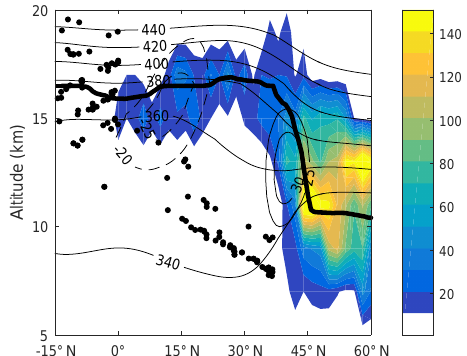
Figure 6. Meteorological conditions in the ASM anticyclone (based on the ERA–Interim reanalysis). PV anomaly (shaded, unit: PVU) in the ASM anticyclone (40–120 ◦ E) with respect to the zonal mean, averaged over summer 2009 (June–August). Zonal wind (black solid lines indicating the westerlies and black dashed lines indi- cating the easterlies) is averaged between 40 and 120 ◦ E. The first thermal tropopause zonally averaged over 0–360 ◦ E is shown as a dashed white line, averaged between 40 to 120 ◦ E.